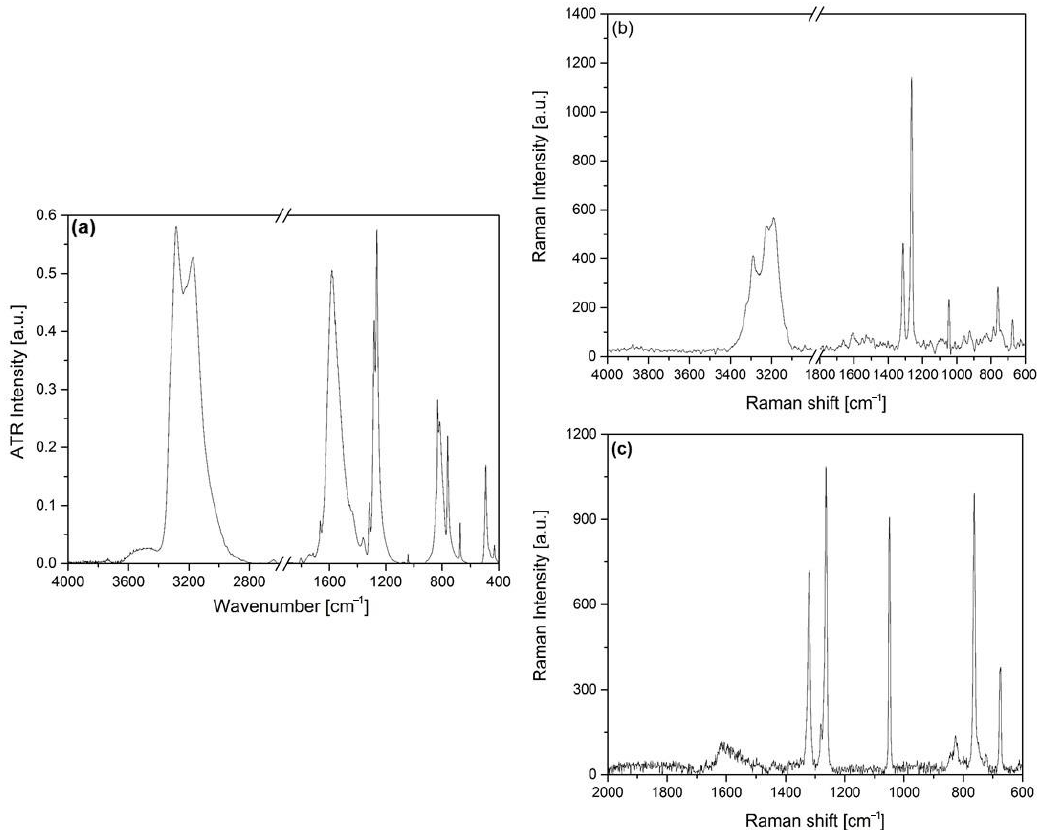
Figure 5. The ( a ) IR (25 ◦ C) and low-temperature Raman spectra ( − 150 ◦ C) in the region of ( b ) the ammonia (532 nm excitation); and ( c ) carbonate (785 nm excitation) vibrational modes.